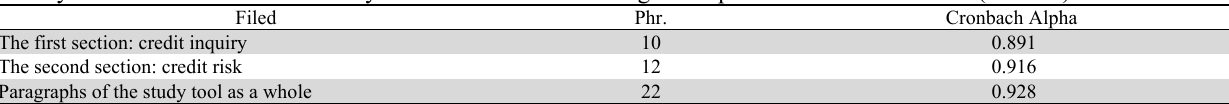
Stability of the dimensions of the study instrument vertebrae using the Alpha Cronbach coefficient (n = 176) Filed Phr.